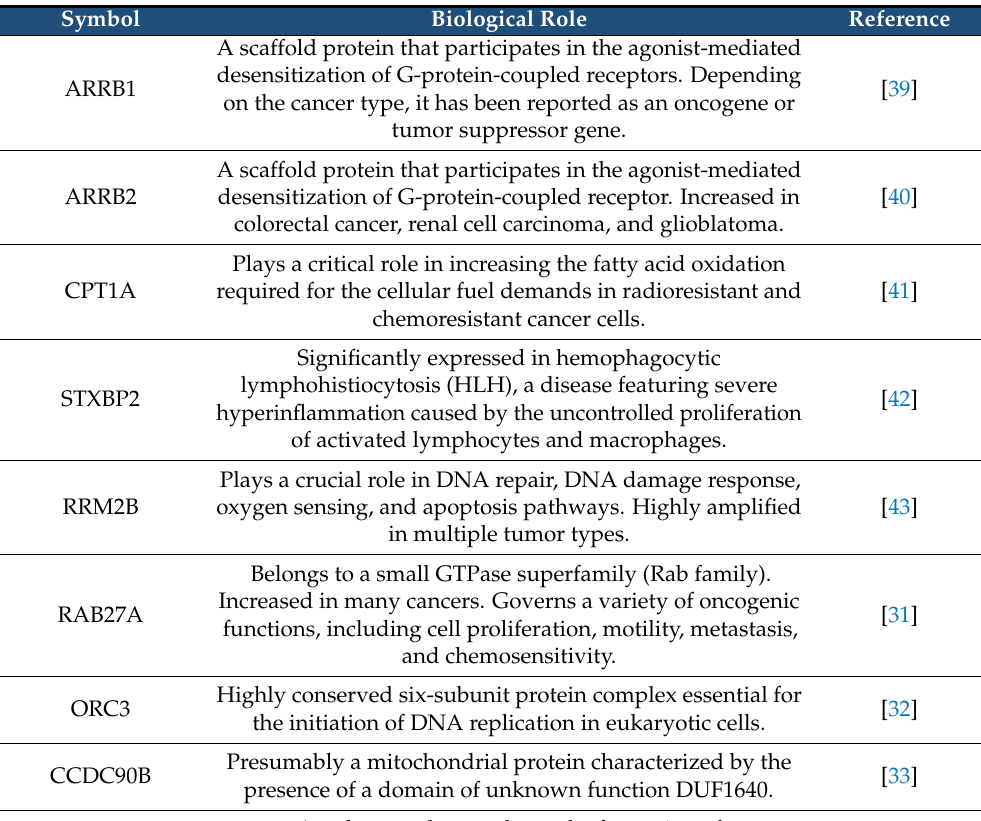
Table 4. Biological role of the top 20 differentially abundant RNA transcripts in RBPMS SG2 and EV